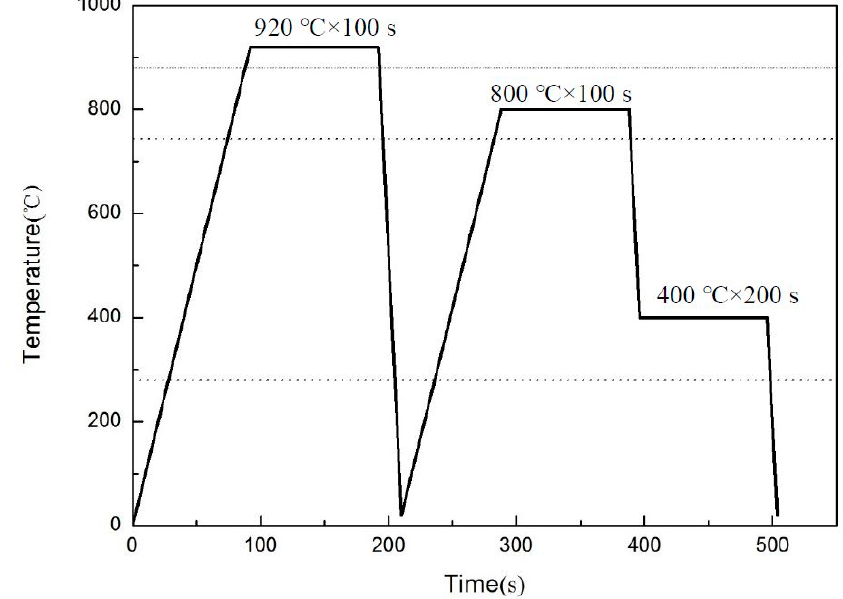
Figure 1. Treatment cycles for producing transformation induced plasticity (TRIP)-assisted annealed martensitic (TAM)